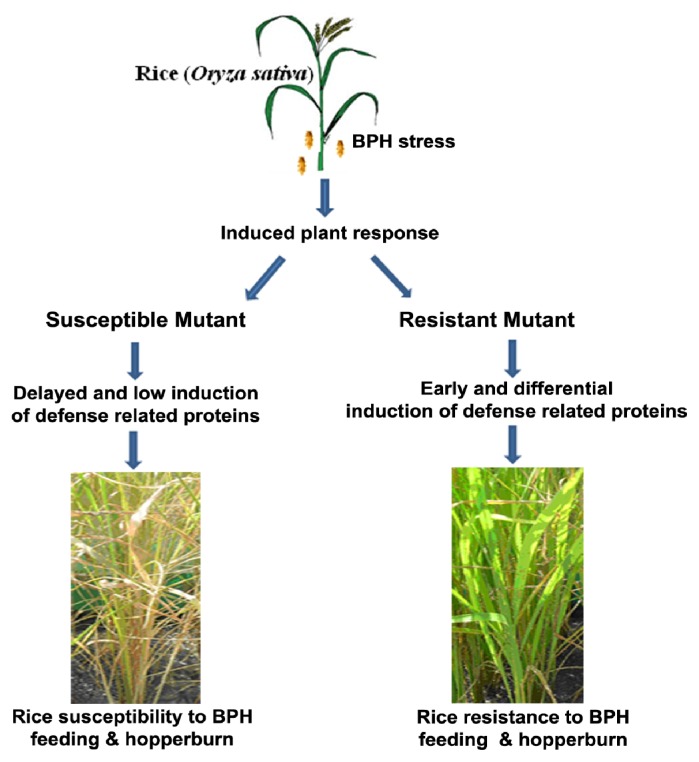
A summarized figure of brown planthopper (N. lugens) induced IR64 proteins. Abundance of various proteins associated with rice resistance is altered following BPH infestation. The resistant lines such as D518 may induce specific genes earlier and more intensely than susceptible lines that interact with other proteins thus leading to their enhanced level of resistance against BPH.